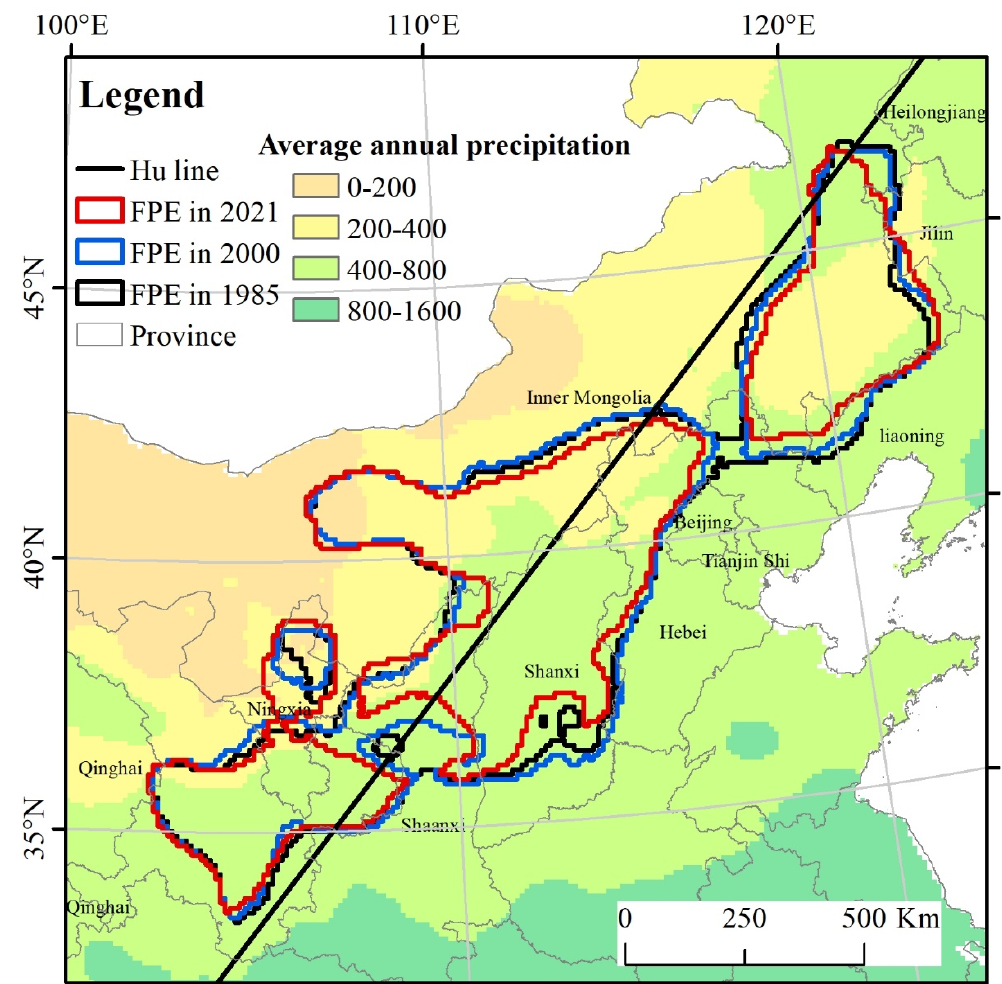
Figure 1. Maps of the farming–pastoral ecotone (FPE) in Northern China in 1985, 2000, and 2021.